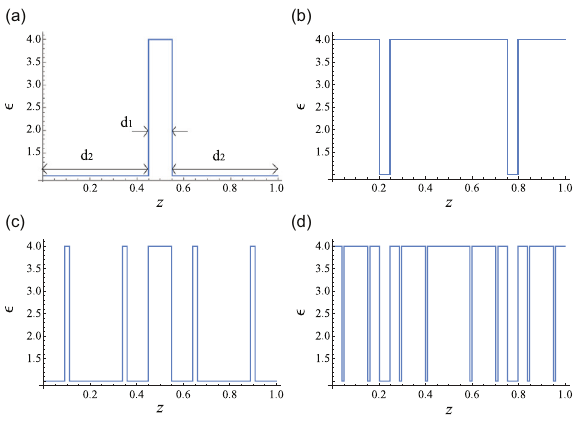
Figure 1. e profile for different orders of fractal MTM. In this example, L = d 1 + 2 · d 2 = 1, d 2 =0.45 L , e 1 = 4 and e 2 = 1. (a) 1st order, (b) 2nd order, (c) 3rd order, (d) 4th order.